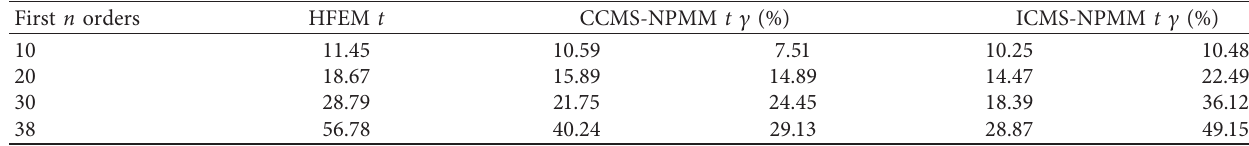
Table 3: Computational time and time saving ratio of three methods.